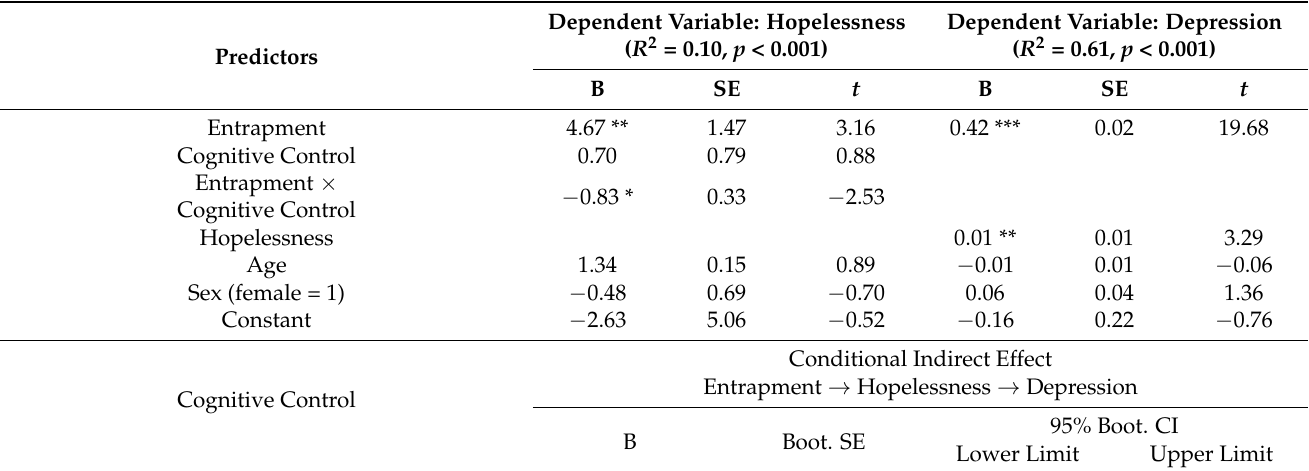
Table 3. Results of moderated mediation analysis (N =